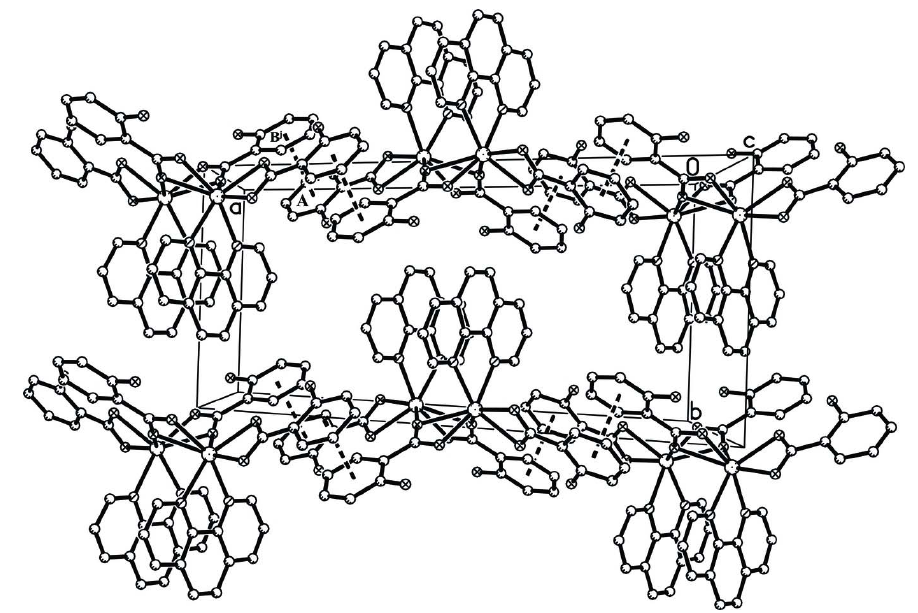
A packing diagram of the title compound, showing a one-dimensional chain-like structure generated by the intermolecular π - π interactions. All H atoms are omitted for clarity. [Symmetry codes: ( j ): 1/2 + x , 1/2 - y , 1/2 + z